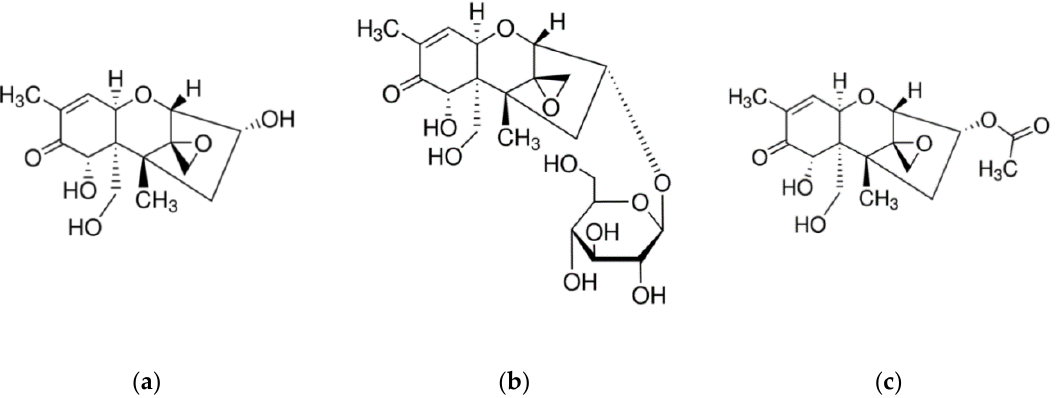
Figure 1. Chemical structures of ( a ) deoxynivalenol (DON); ( b ) DON-3-glucoside; and ( c )